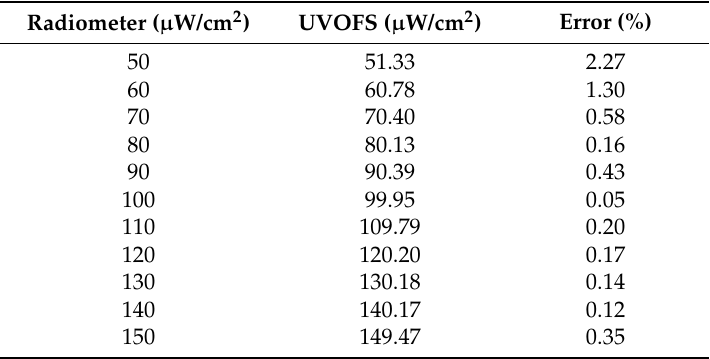
Table 1. The error analysis of the La 2 O 2 S:Eu-based